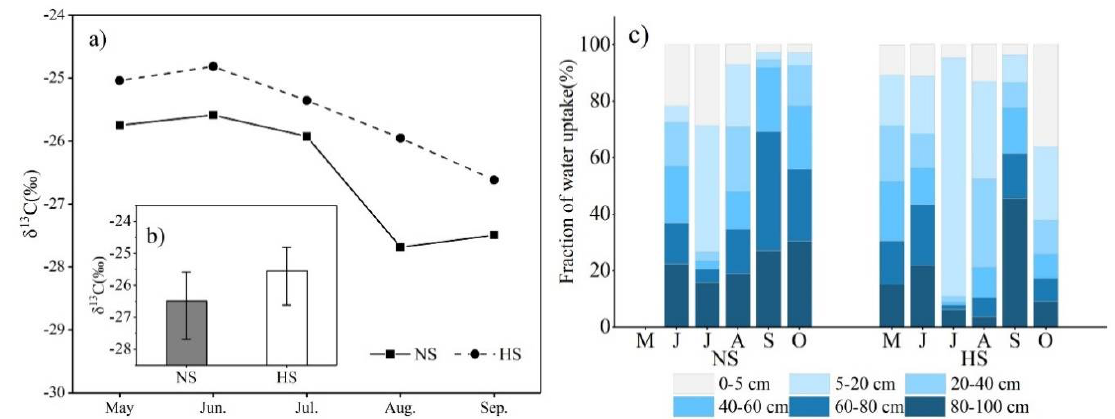
Figure 7. ( a ) Shrub water use efficiency (reflected by foliage δ 13 C) in NS and HS across the growing season; ( b ) average δ 13 C of two groups from May to September; ( c ) shrub water uptake fraction of 0–100 cm soil water.